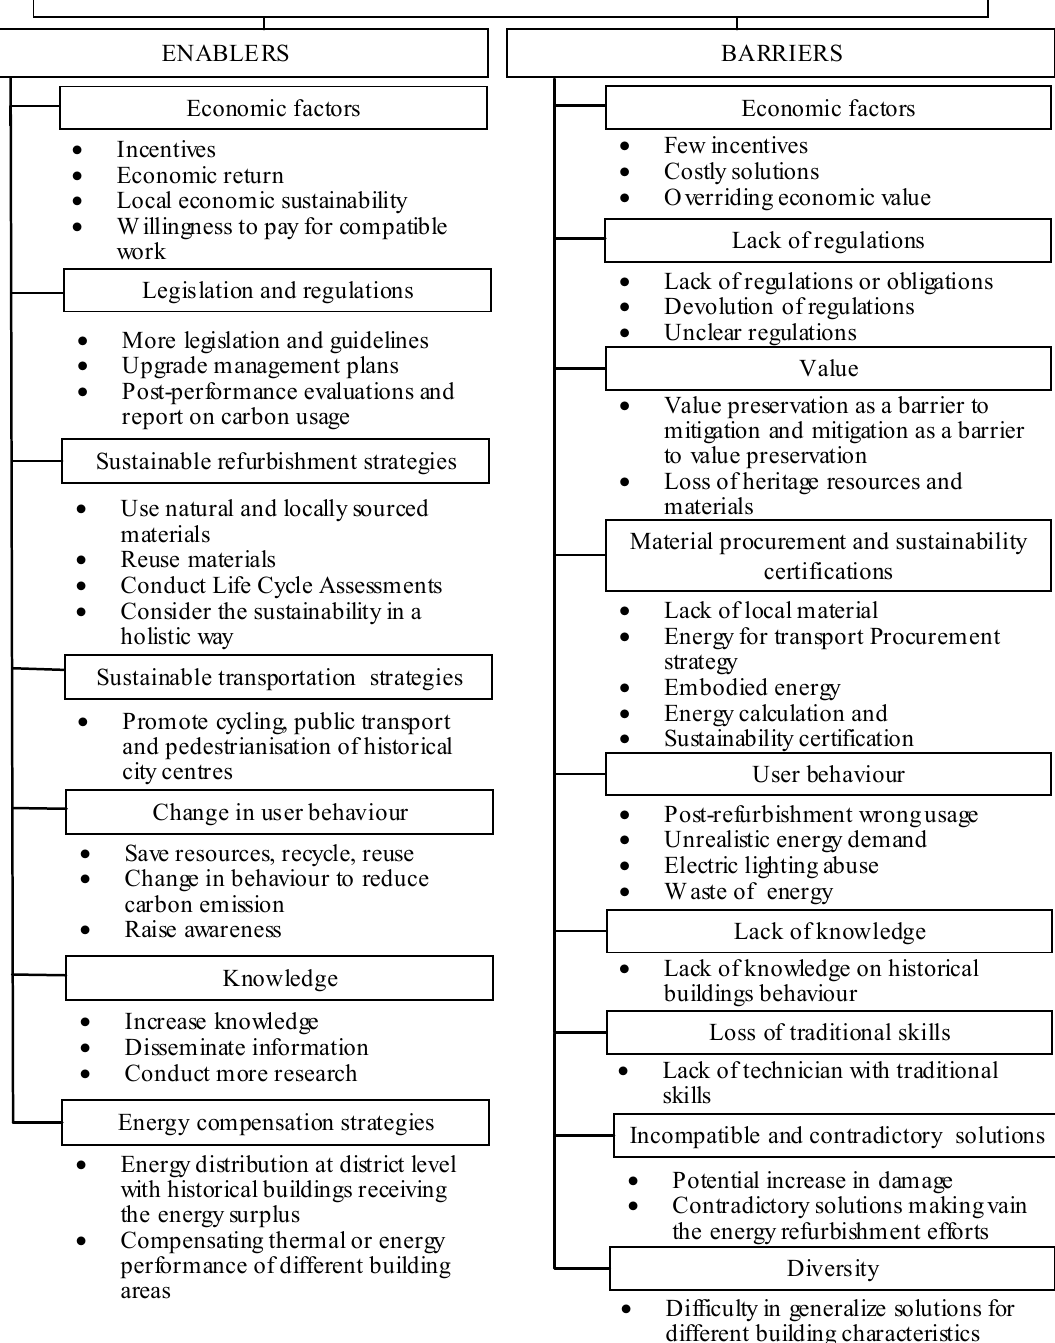
Figure 5. Summary of the research findings.